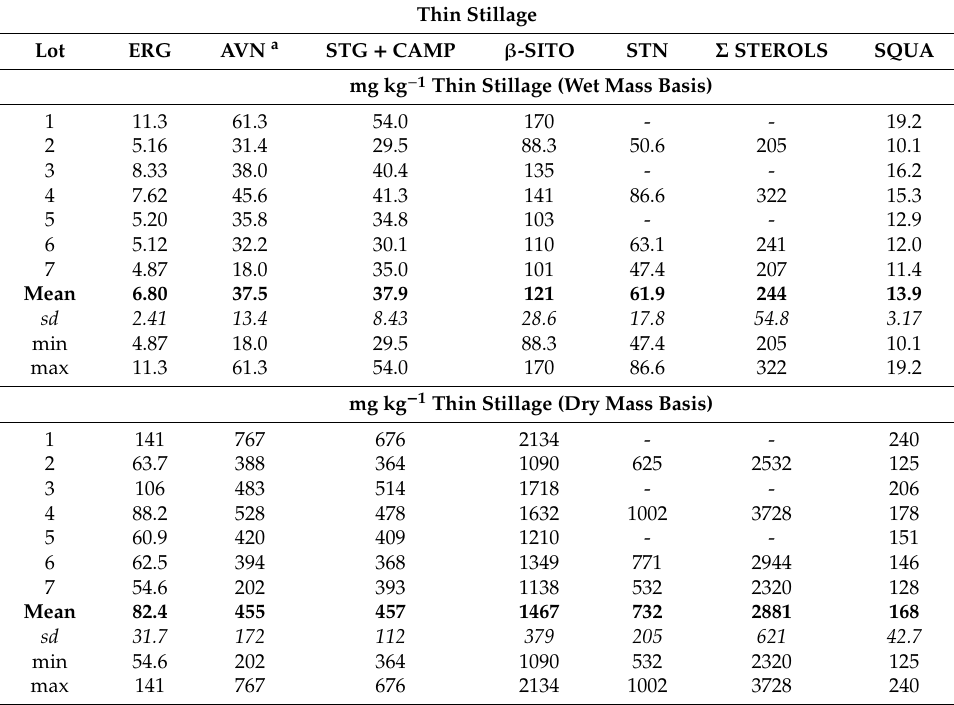
Table 2. Total amounts of phytosterols and squalene in thin stillage from a dry-grind corn ethanol plant. Data refer to individual lots collected at monthly intervals from July 2018 to April 2019 and overall mean, standard deviation ( sd ), and range of values observed ( n = 7) *. Thin Stillage Lot ERG AVN a STG + CAMP β -SITO STN Σ STEROLS